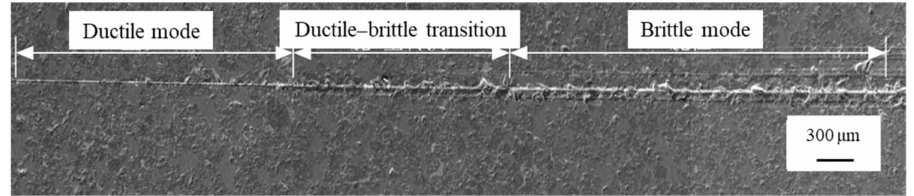
Figure 5. Overall surface morphology of the scratched RB-SiC ceramic sample at v s = 10